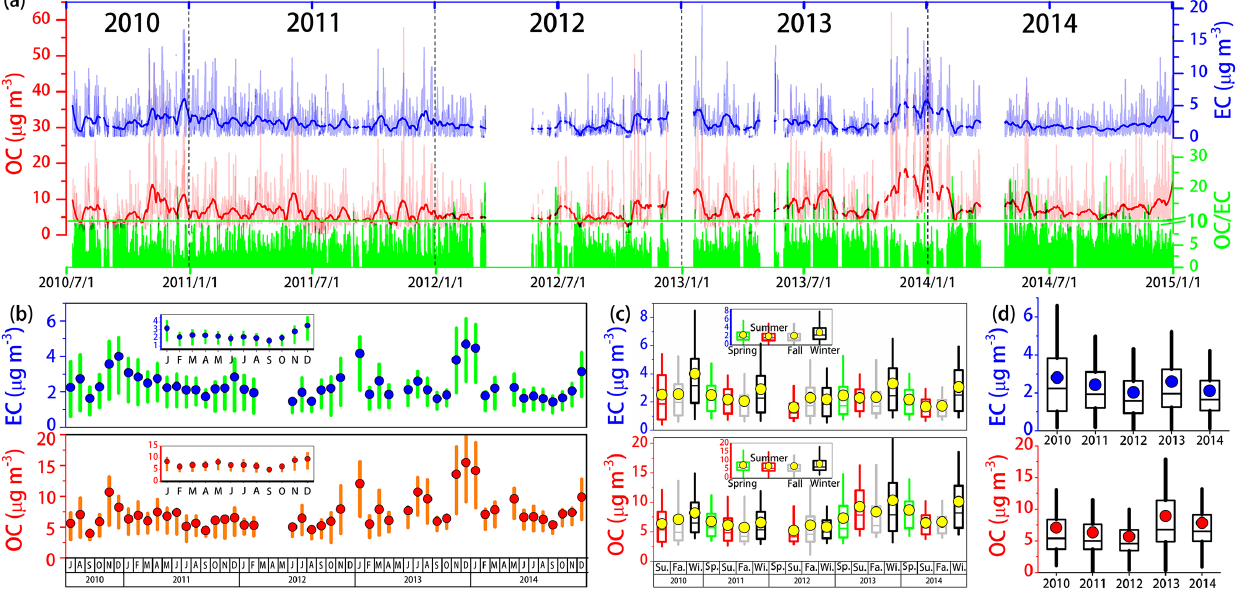
Figure 6. Hourly (a) , monthly (b) , seasonal (c) , and interannual (d) variations of OC and EC mass concentrations in Shanghai. Note that the variations of OC / EC are also shown in (a) , setting 10 as the breaking point. The relatively small figures in (b) and (c) represent the overall monthly and seasonal mass concentrations of OC and EC throughout our study period,